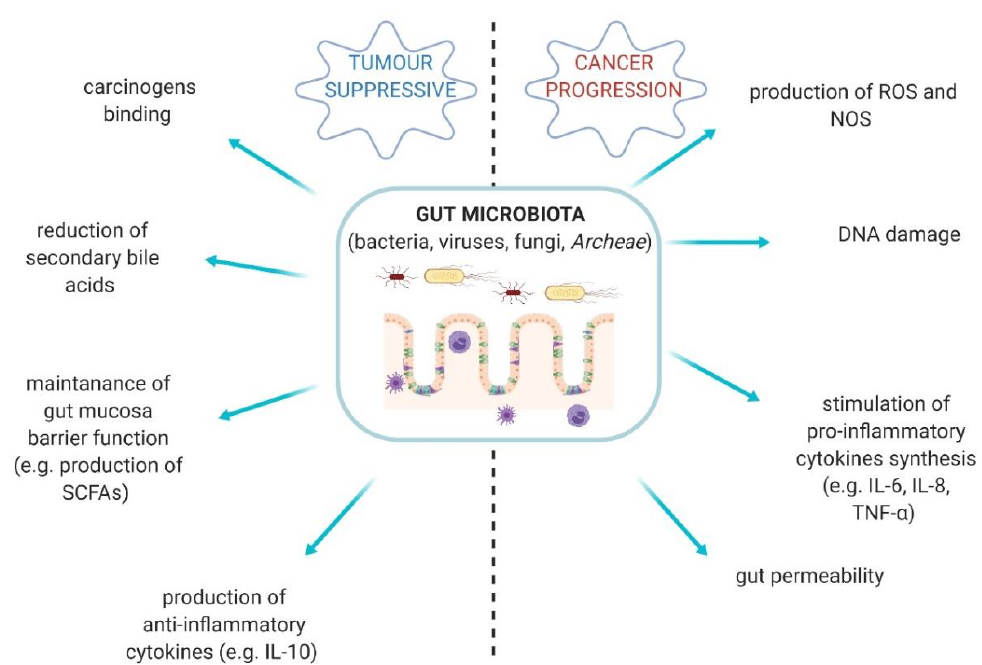
Figure 1. The diversity of gut microbiota activities — tumour suppressive conditions vs. cancer progression. SCFAs — short-chain fatty acids; ROS — reactive oxygen species; NOS — nitric oxygen synthase [2 – 4].